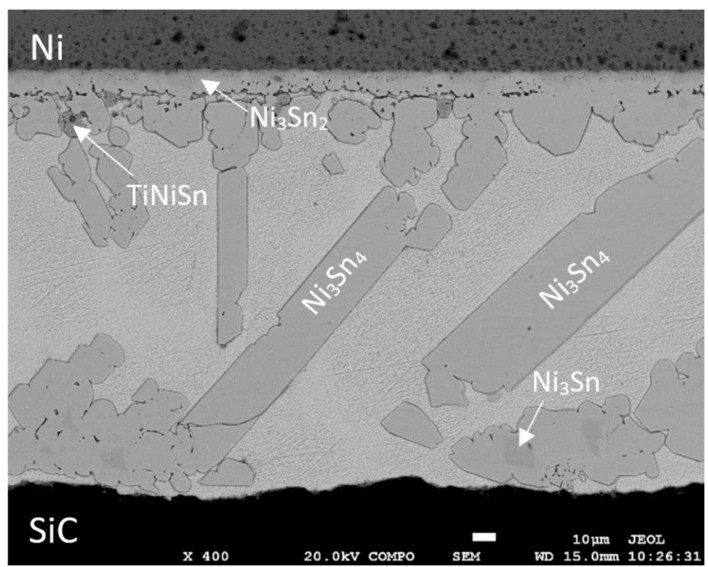
Figure 11. Microstructure of SiC/Sn5Sb3Ti/Ni joint from SEM analysis performed in BSE